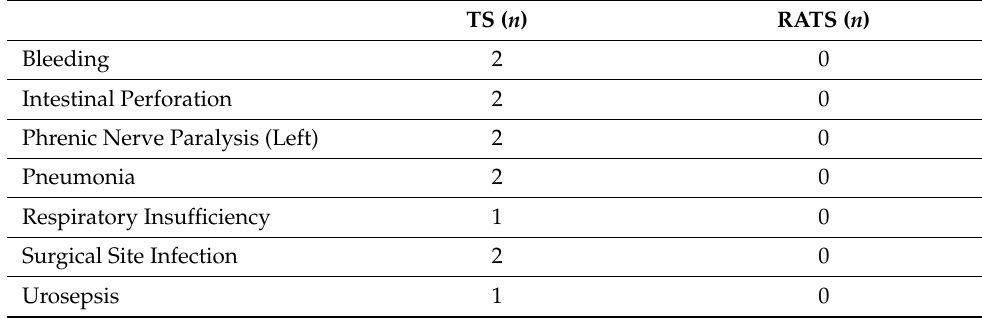
Table 4. Postoperative